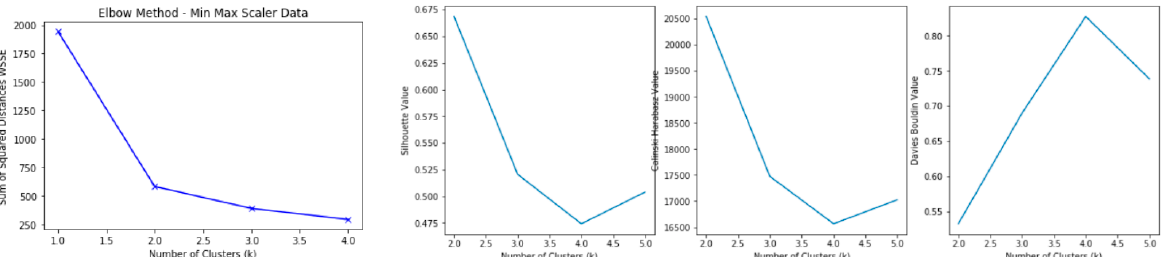
Figure 12. Metrics change for the min-max-scaled data .